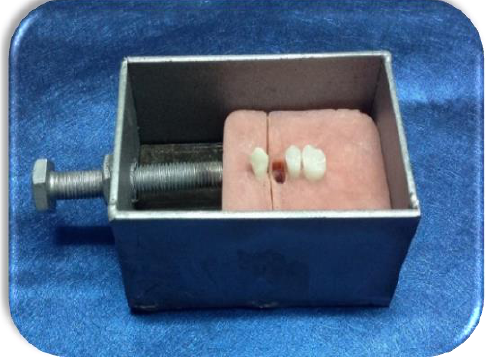
Figure 1: Template for teeth fixation. Forty sound maxillary first premolar